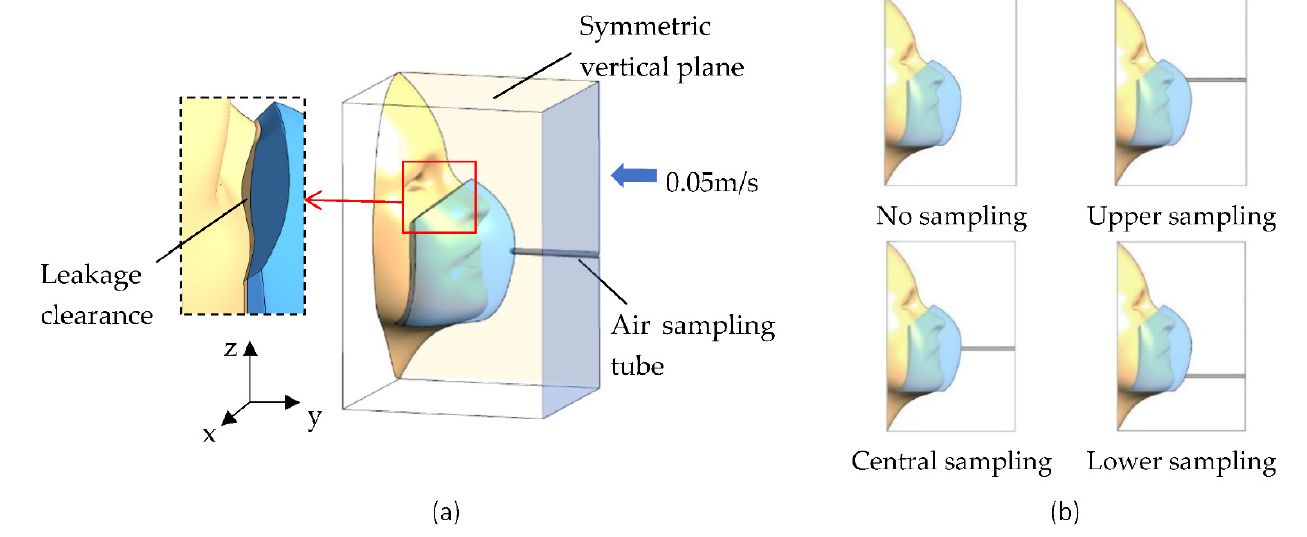
Figure 4. Geometry model of a female adult wearing an N95 mask: ( a ) overview of the model, ( b ) modeling cases with different air sampling positions.